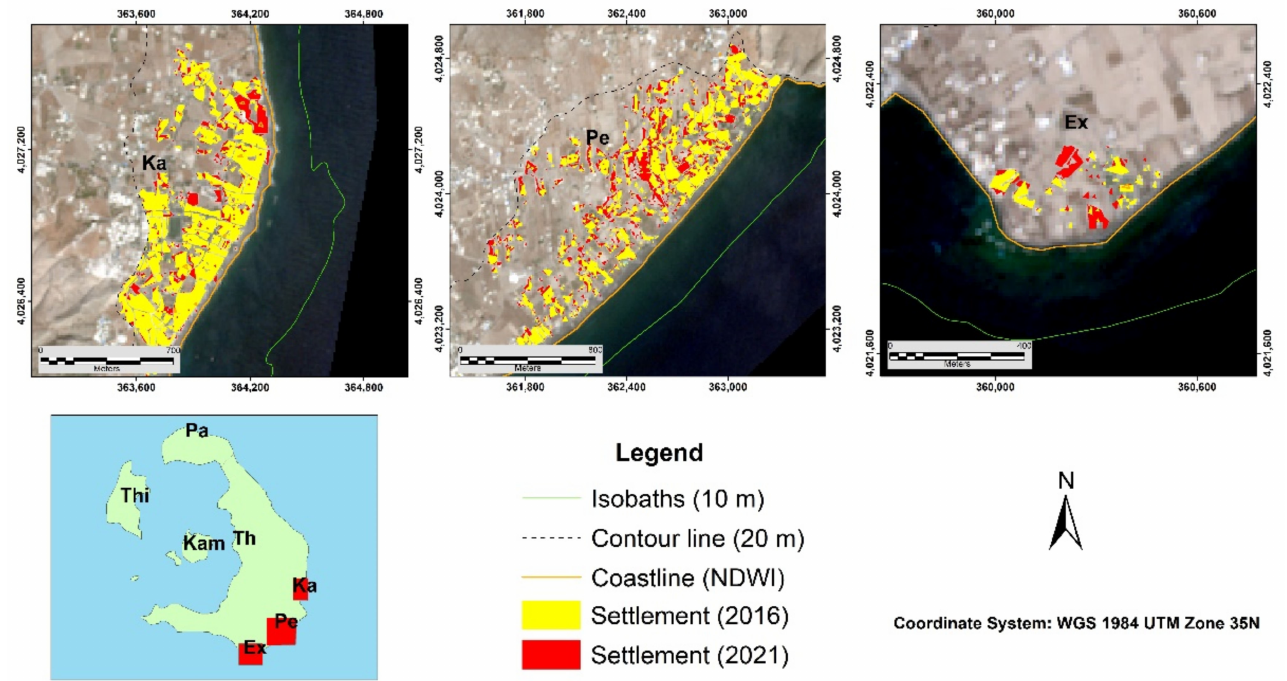
Figure 15. The map is illustrating the urban changes during the period 2016–2021 in Kamari, Perissa, and Exomiti settlements. Yellow- and red-color polygons represent the urban identification in 2016 and 2021. The orange line is the coastline derived from NDWI, the green line is the isobath (10 m) extracted by the SDB, and the black dashed lines are the upper limit of the landward region regarding the elevation of 20 m.